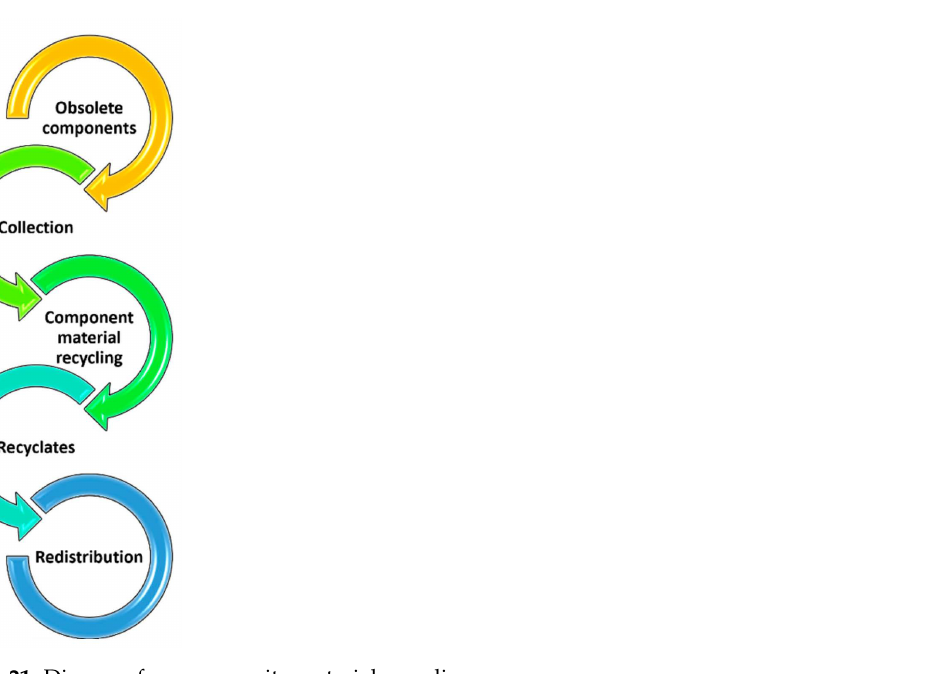
Figure 21. Diagram for a composite material recycling